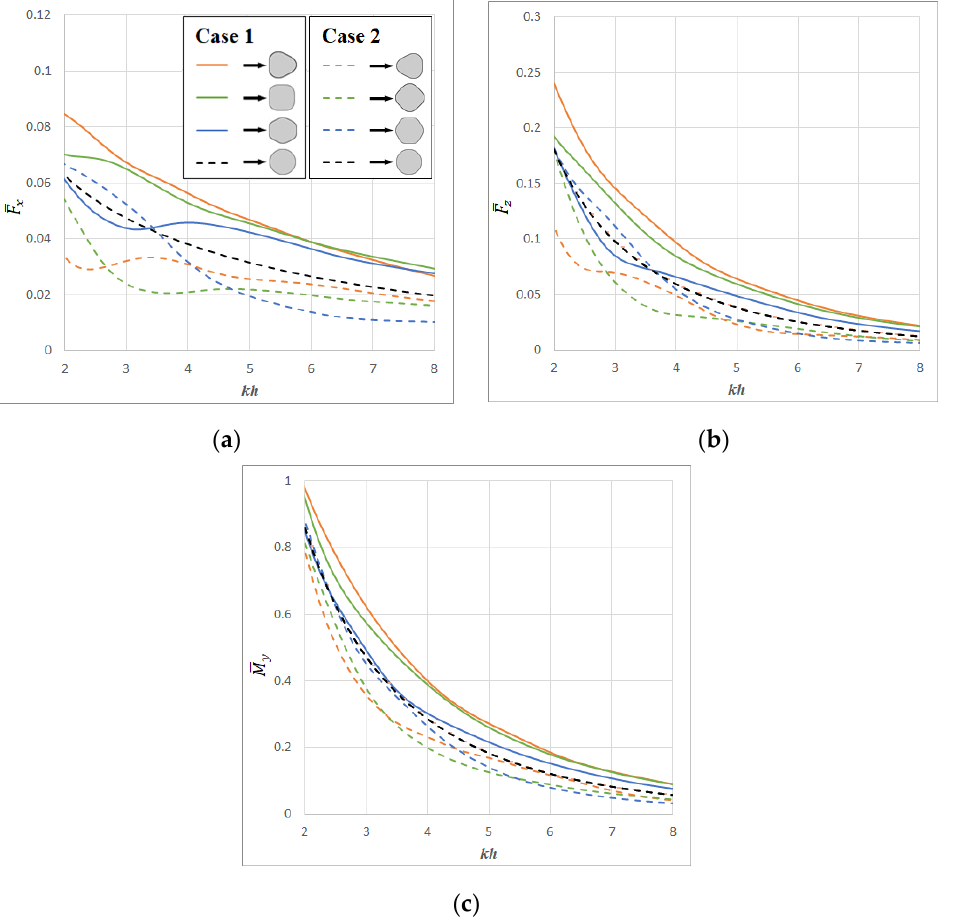
Figure 7. Comparison of wave exciting forces for different platform shapes: ( a ) surge force; ( b ) heave force; and ( c ) pitch moment.